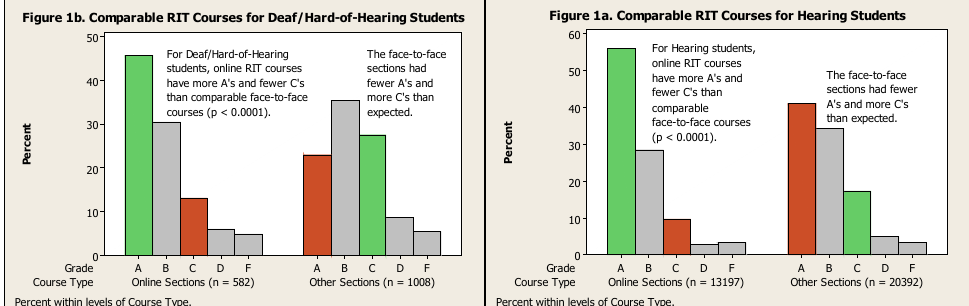
Figure 1b. Comparable RIT Courses for Deaf/Hard-of-Hearing Students Figure 1a. Comparable RIT Courses for Hearing Students